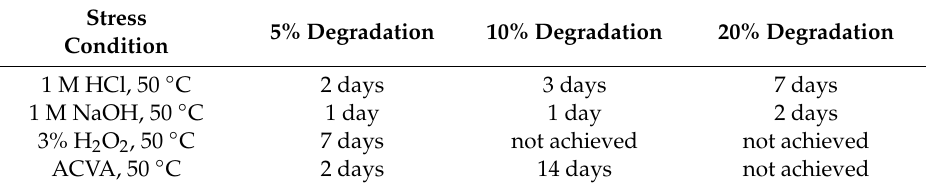
Table 1. Representation of conditions where degradation thresholds were achieved.